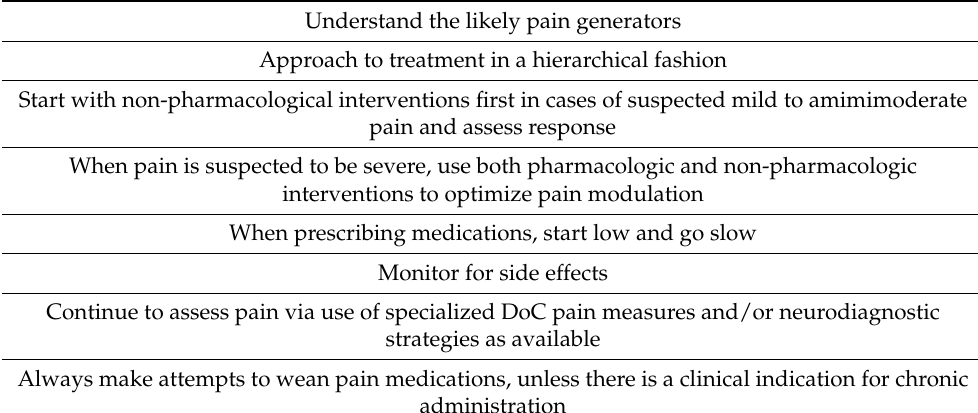
Table 3. Pain Management Caveats in Persons with a